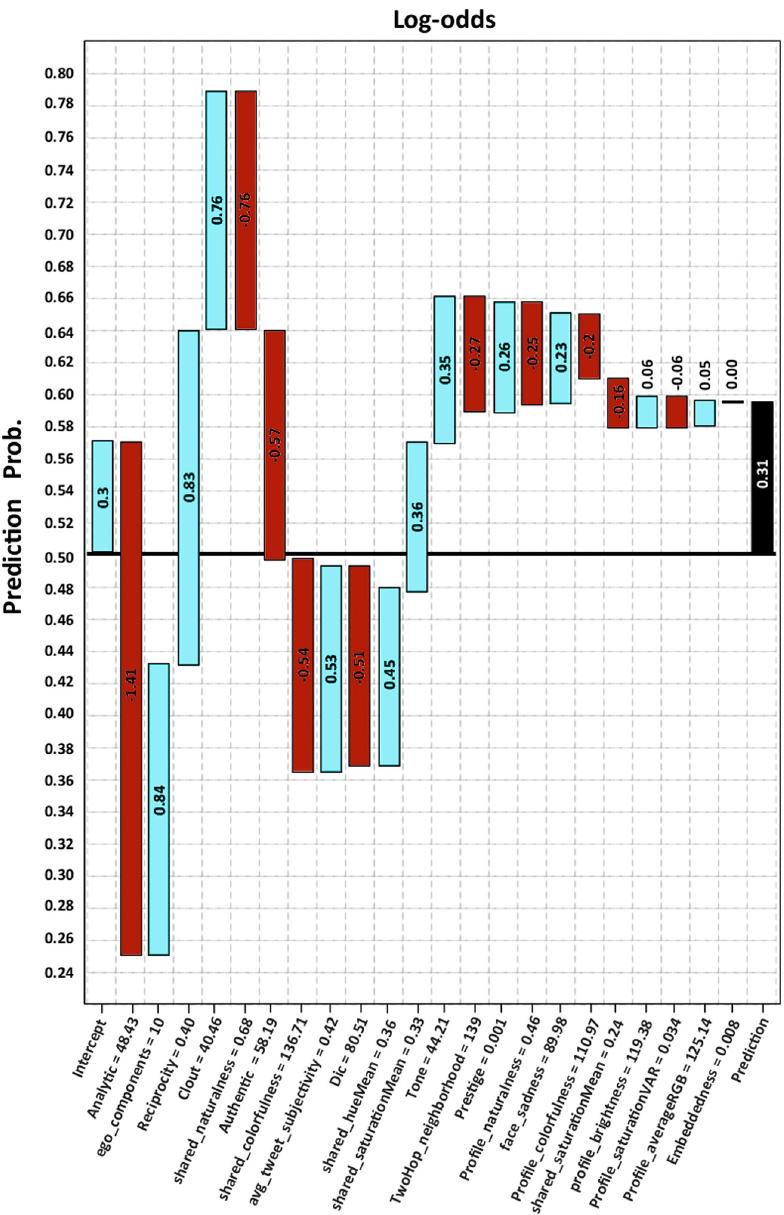
Fig 6. The explanation of the log-odds prediction of outcome (0.31) for a sample user (y-axis shows the outcome probability (depressed or control), the bar labels indicate the log-odds impact of each feature).